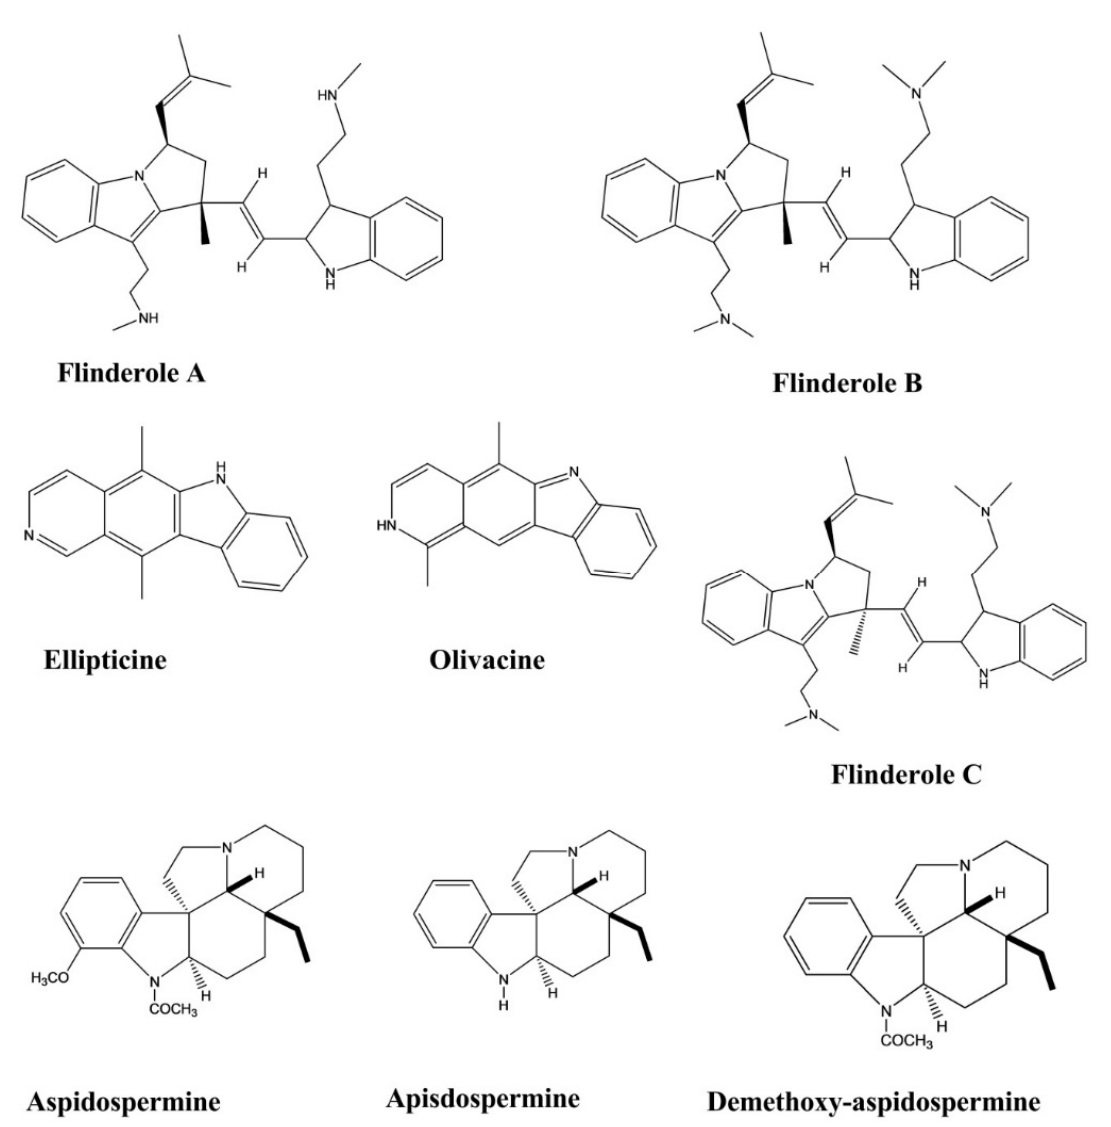
Figure 9. Antimalarial activity of indole alkaloids.